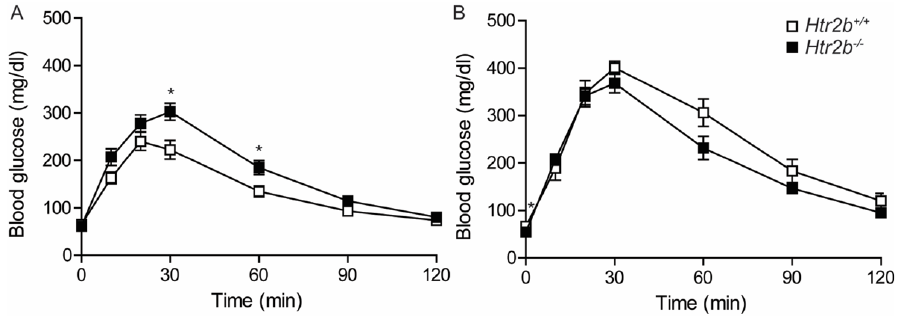
Figure 11. Oral glucose tolerance in Htr2b +/+ ( ☐ ) and in Htr2b −/− ( ◼ ) mice . ( A ): Oral glucose tolerance of non-pregnant females ( n = 10 for Htr2b +/+ and n = 12 for Htr2b −/− ). ( B ): Oral glucose tolerance of − / − ance of non‑pregnant females ( n = 10 for Htr2b +/+ and n = 12 for Htr2b ). ( B ): Oral glucose tolerance P17.5 pregnant Htr2b +/+ ( ☐ n = 4) and Htr2b −/− mice ( ◼ n = 10). Data are presented as mean ± SEM. * − / − of P17.5 pregnant Htr2b +/+ ( □ n = 4) and Htr2b mice ( ■ n = 10). Data are presented as mean ± SEM. p < 0.05. * p <